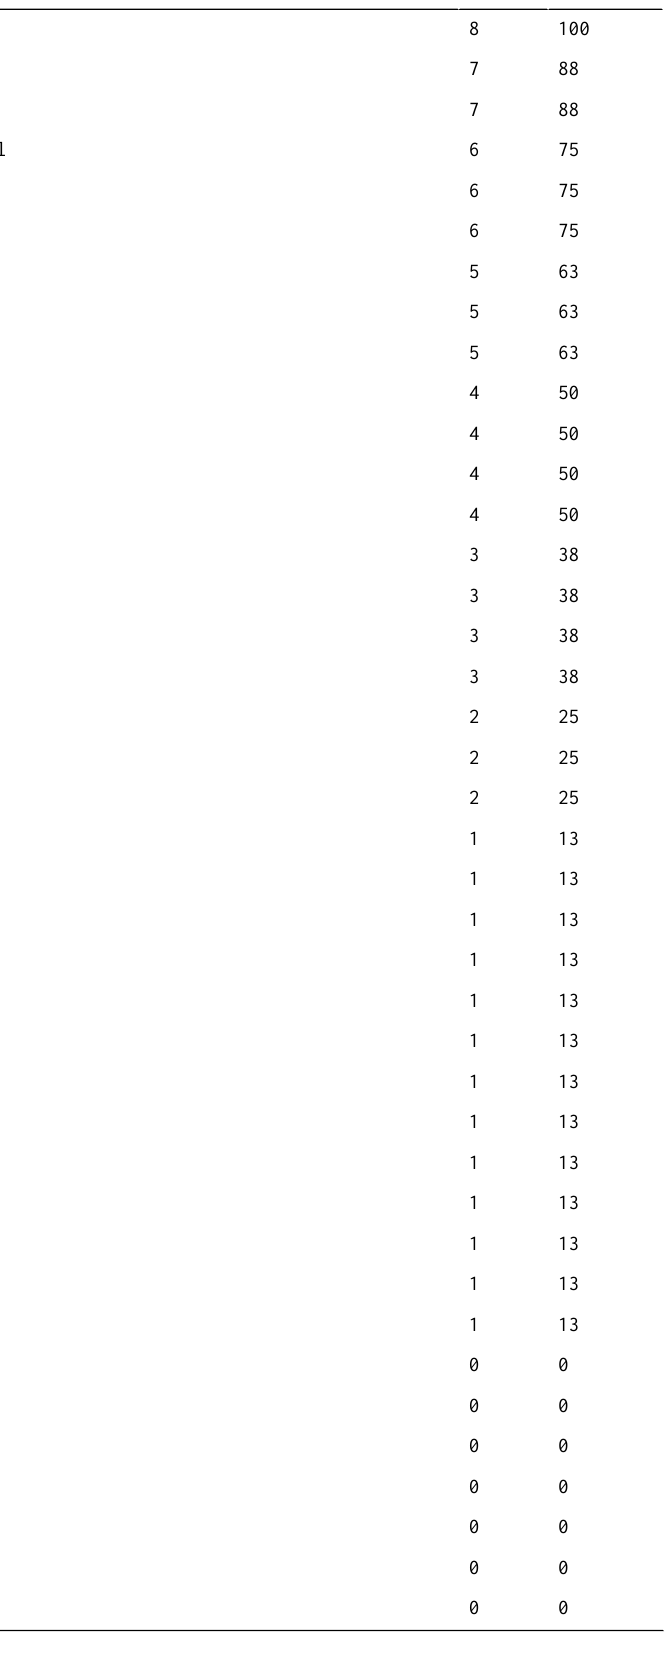
Table 5. Frequencies of behavioral change techniques (BCTs) used in the interventions discussed in the articles (n=8). %nBCT# 1008Provide feedback on